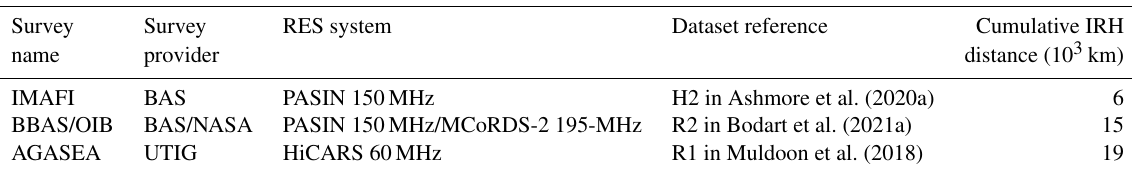
Figure 1. Map of the datasets and key locations in this study. The three datasets that contain the 4.72ka IRH are colour-coded as IMIS (green), PIG (blue), and THW (pink). IRH data where D > 1 are excluded (see Sect. 2.2.1; Fig. S1). Points represent the snow, firn, and ice cores used in this study to compare modern accumulation rates with those inferred from the 4.72ka IRH (Sect. 2.4). The background colour map shows modern surface speeds from Rignot et al. (2017). Locations mentioned in this paper are abbreviated on the map as follows: BYRD (Byrd Ice Core), IMIS (Institute and Möller ice streams), PIG (Pine Island Glacier), THW (Thwaites Glacier), WAIS (West Antarctic Ice Sheet), CD (Central Amundsen–Weddell–Ross Divide), WD14 (WAIS Divide ice core). Major ice divides are from Mouginot et al. (2017). The background image is the 2014 MODIS mosaic of Antarctica (Haran et al., 2018). For all analyses and figures in this study, the SCAR Antarctic Polar Stereographic projection is used (PSX/PSY; EPSG: 3031). Table 1. Characteristics of each IRH dataset used in this study that contain the 4.72ka IRH. “Reflector 1” in Muldoon et al. (2018) is abbreviated here as